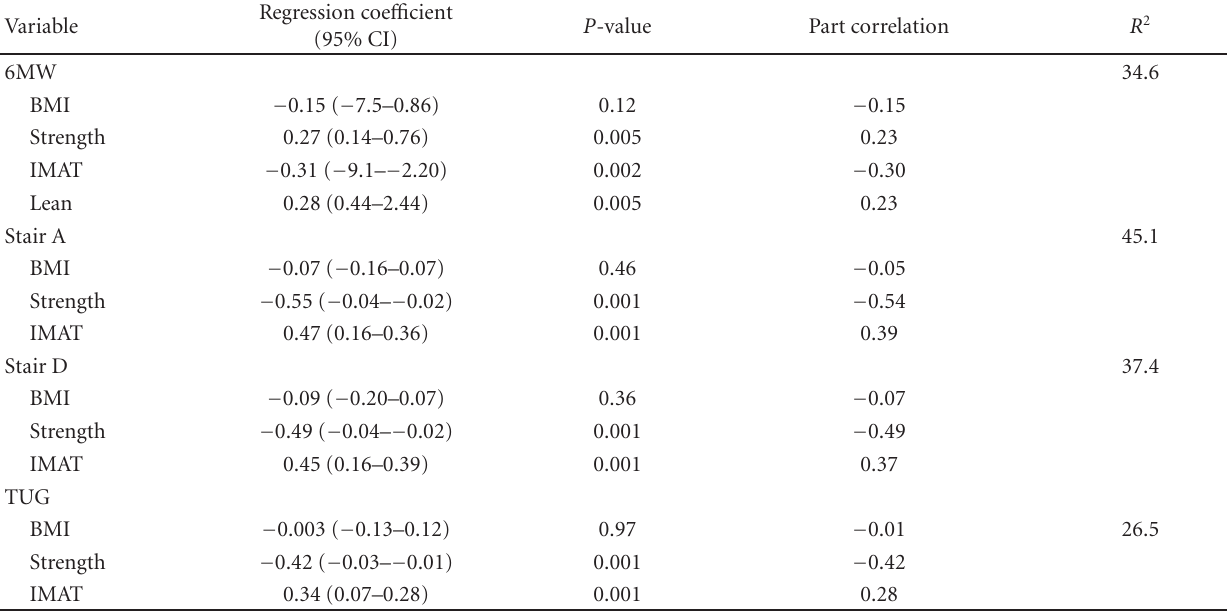
Table 3: Hierarchical regression results. six minute walk (6MW), stair ascent (stair A), stair descent (stair D), timed up and go (TUG).